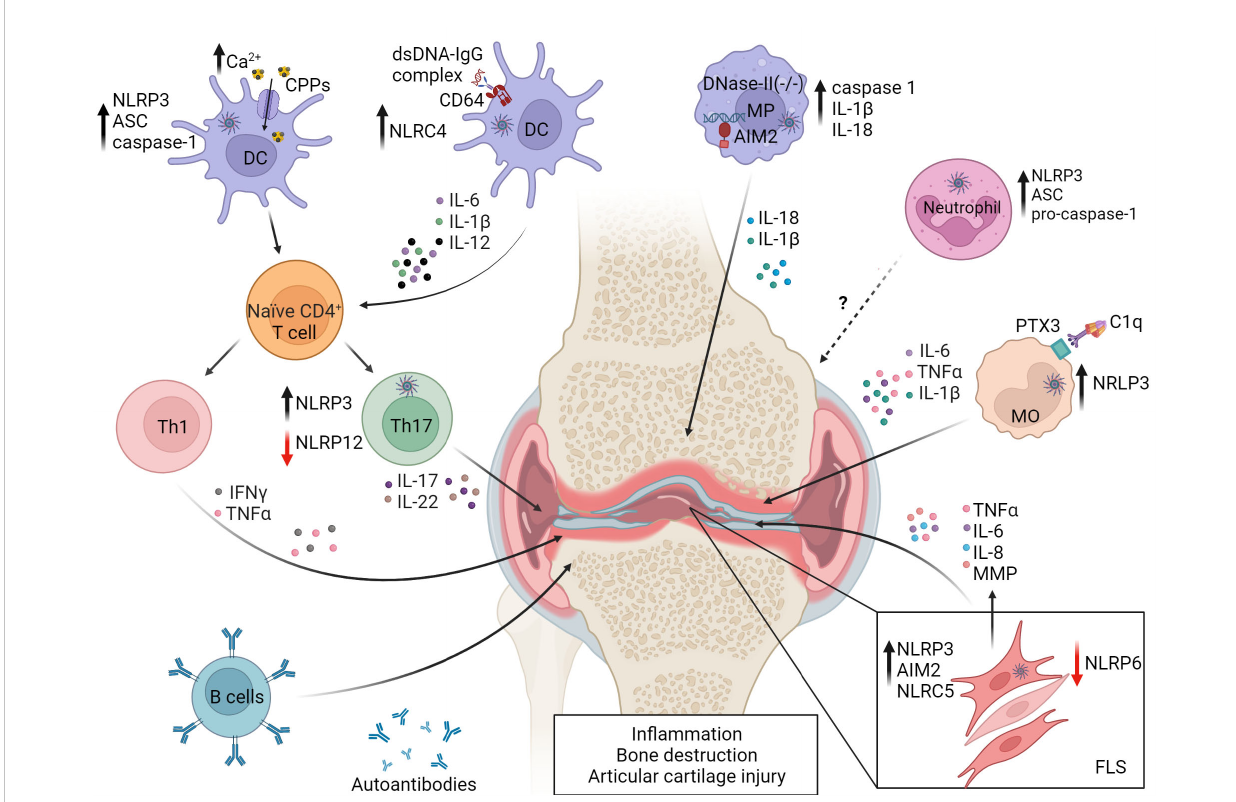
FIGURE 3 Events in dysregulated in fl ammasome activation in rheumatoid arthritis (RA). NLRP3 and NLRC4 activity are increased in monocytes (MO) and DC by Fc-receptor (FcR) binding of DNA-IgG immune complexes and complement component 1q (C1q) binding to pentraxin 3 (PTX3). Uptake of elevated levels of calciprotein particles (CPPs) in the joint by resident DC also leads to NLRP3 activation. Resulting pyroptosis and secretion of proin fl ammatory cytokines promote RA progression by favoring Th1 and Th17 differentiation and development of autoantibodies and RA factor producing plasma cells. NLRP3 activation is also increased in Th17 cells. Aberrant lysosomal processing of endocytosed dsDNA can lead to AIM2 activation in joint resident macrophages (MP). Neutrophils exhibit reduced expression of in fl ammasome molecules, which correlates with decreased disease severity. NLRP3, NLRC5 and AIM2 are associated with proin fl ammatory properties of fi broblast-like synoviocytes (FLS), while NLRP6 and NLRP12 serve protective roles, indicated by the red arrows. NLRP6 limits FLS cytokine production, and NLRP12 negatively regulates Th17 subset differentiation. Reduced expression of NLRP6 and NLRP12 leads to pathology. Matrix metalloproteinases (MMP). The fi gure was prepared using Biorender software licensed to the UNC Lineberger Comprehensive Cancer